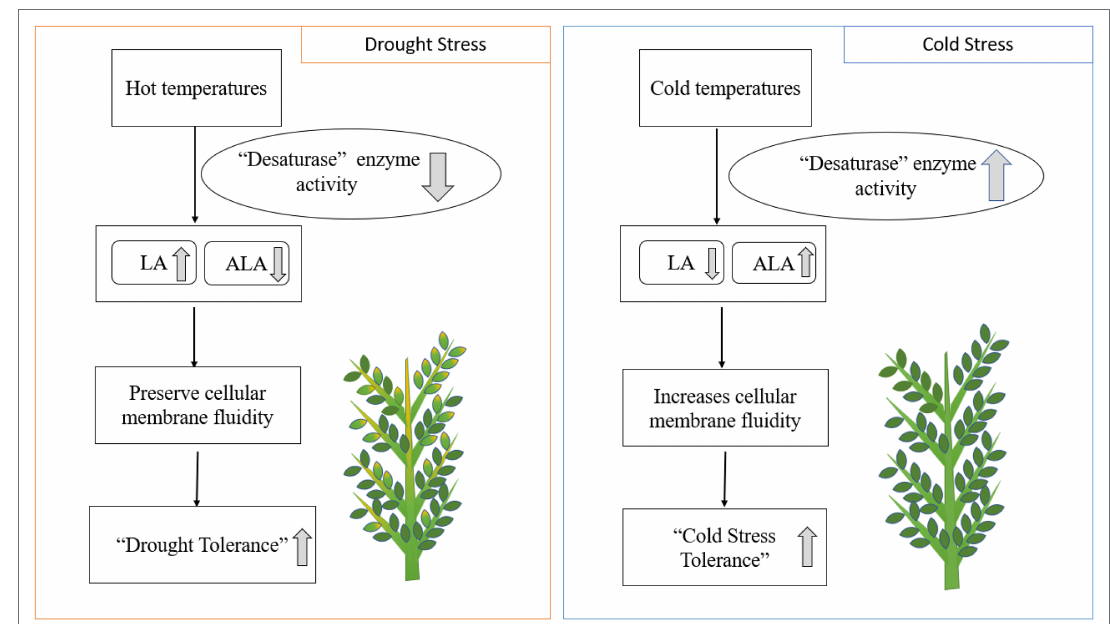
FIGURE 4 | Drought and cold stresses impact enzymatic activity and EFA composition in plants. LA; linoleic acid. ALA; alpha-linolenic